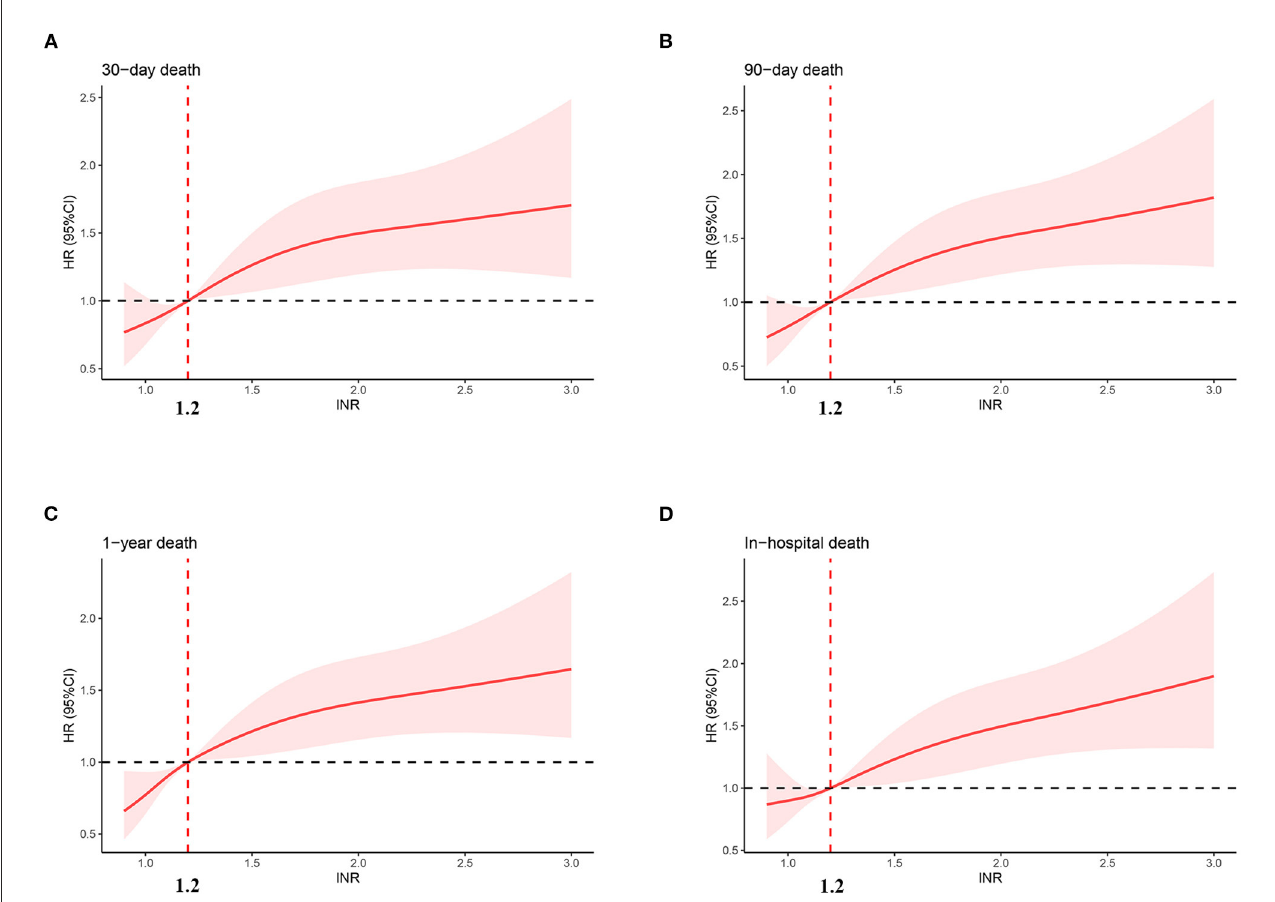
FIGURE2 Association between INR and hazard ratio of 30-day (A) , 90-day (B) , 1-year (C) , and in-hospital (D) all-cause death. INR, international normalized ratio.